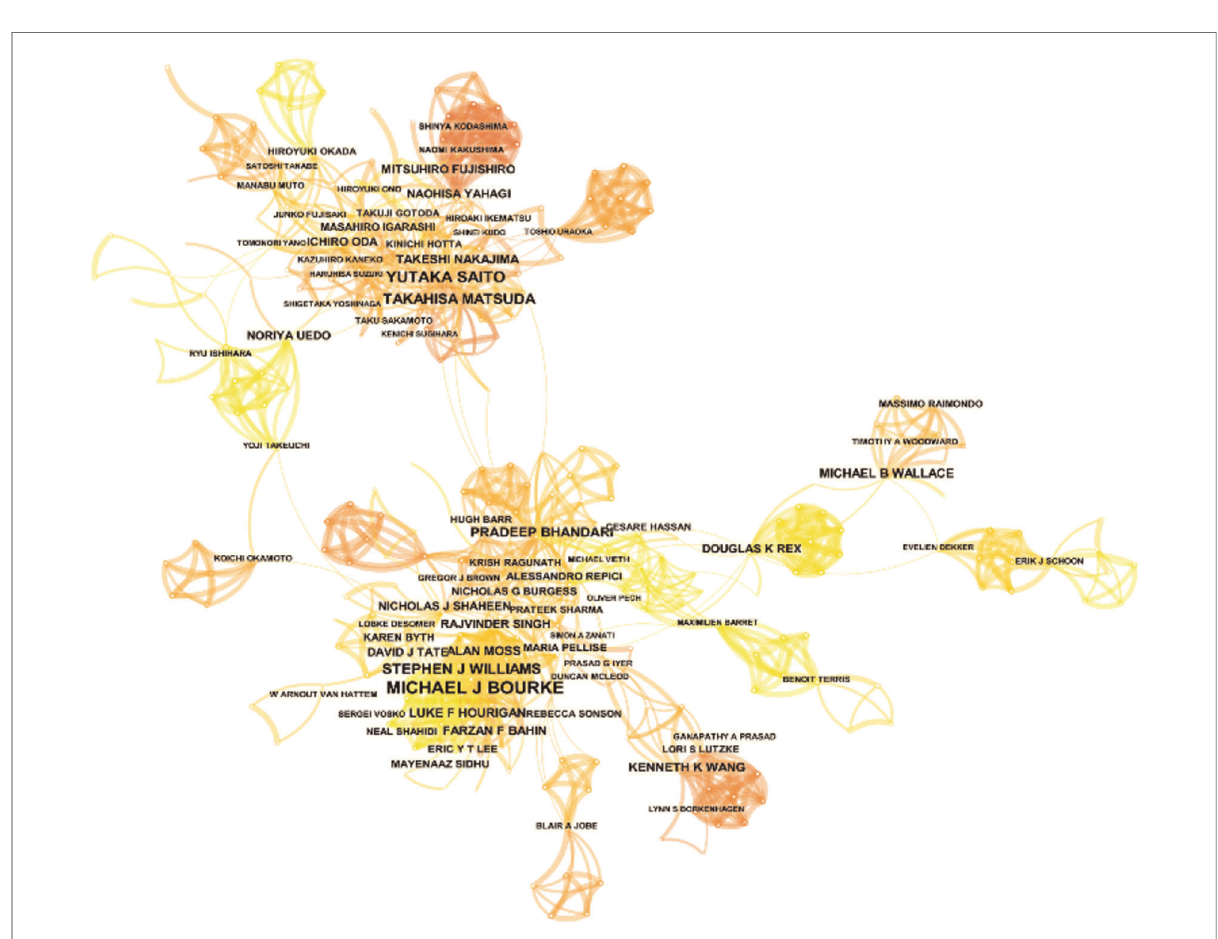
FIGURE 4 Co-occurrence map based on